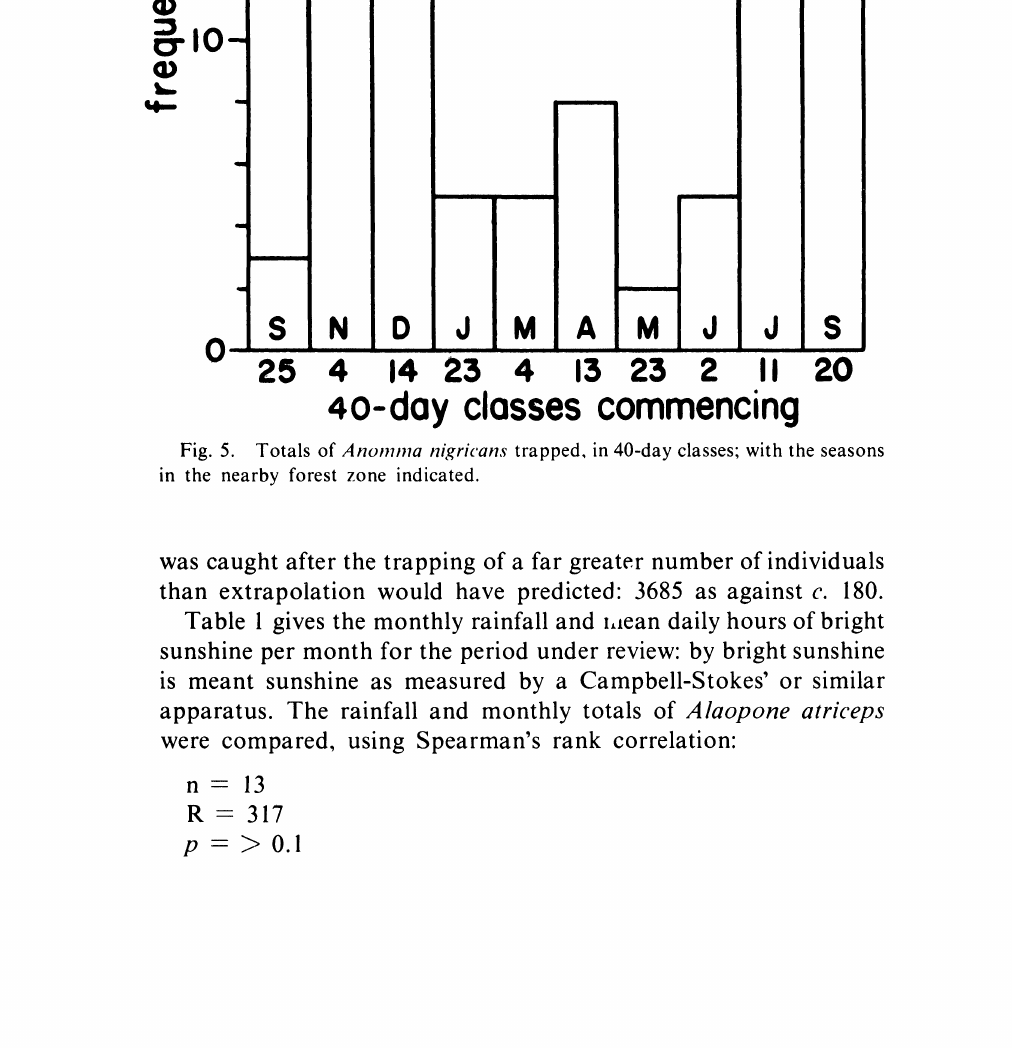
Fig. 5. Totals of Anomma nigricans trapped, in 40-day classes; with the seasons in the nearby forest zone indicated.